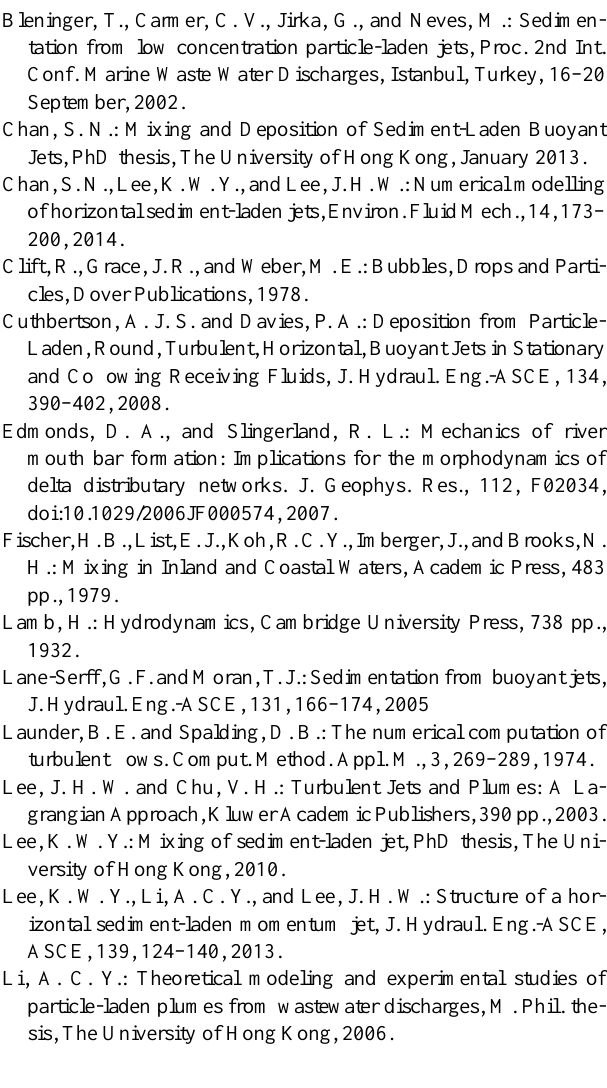
1977. Figure 5. Comparison of predicted and measured profiles of cross- Fig. 5. Comparison of predicted and measured profiles of cross- sectional sediment concentration normalized against the maxi- sectional sediment concentration normalized against the maximum concentration at the section C/C max , plastic IP3 particle 716 µ m, mum concentration at the section C/C max , plastic IP3 particle, u 0 = 0 . 59ms − 1 , w s = 2 . 2cms − 1 , l m = 34 . 5 D (a) x = 12 . 5 D < u 0 = 0 . 59 m/s, w s = 2 . 2 cm/s, l m = 34 . 5 D (a) x = 12 . 5 D < l m , (b) x = 50 D > l m . D = 6 mm. The dashed circle is the jet top-hat l m , (b) x = 50 D > l m . D = 6mm. The dashed circle is the jet top- √ profile defined by b T = √ 2 βx (Lee and Chu, 2003). 2 βx (Lee and Chu, hat profile defined by b T =